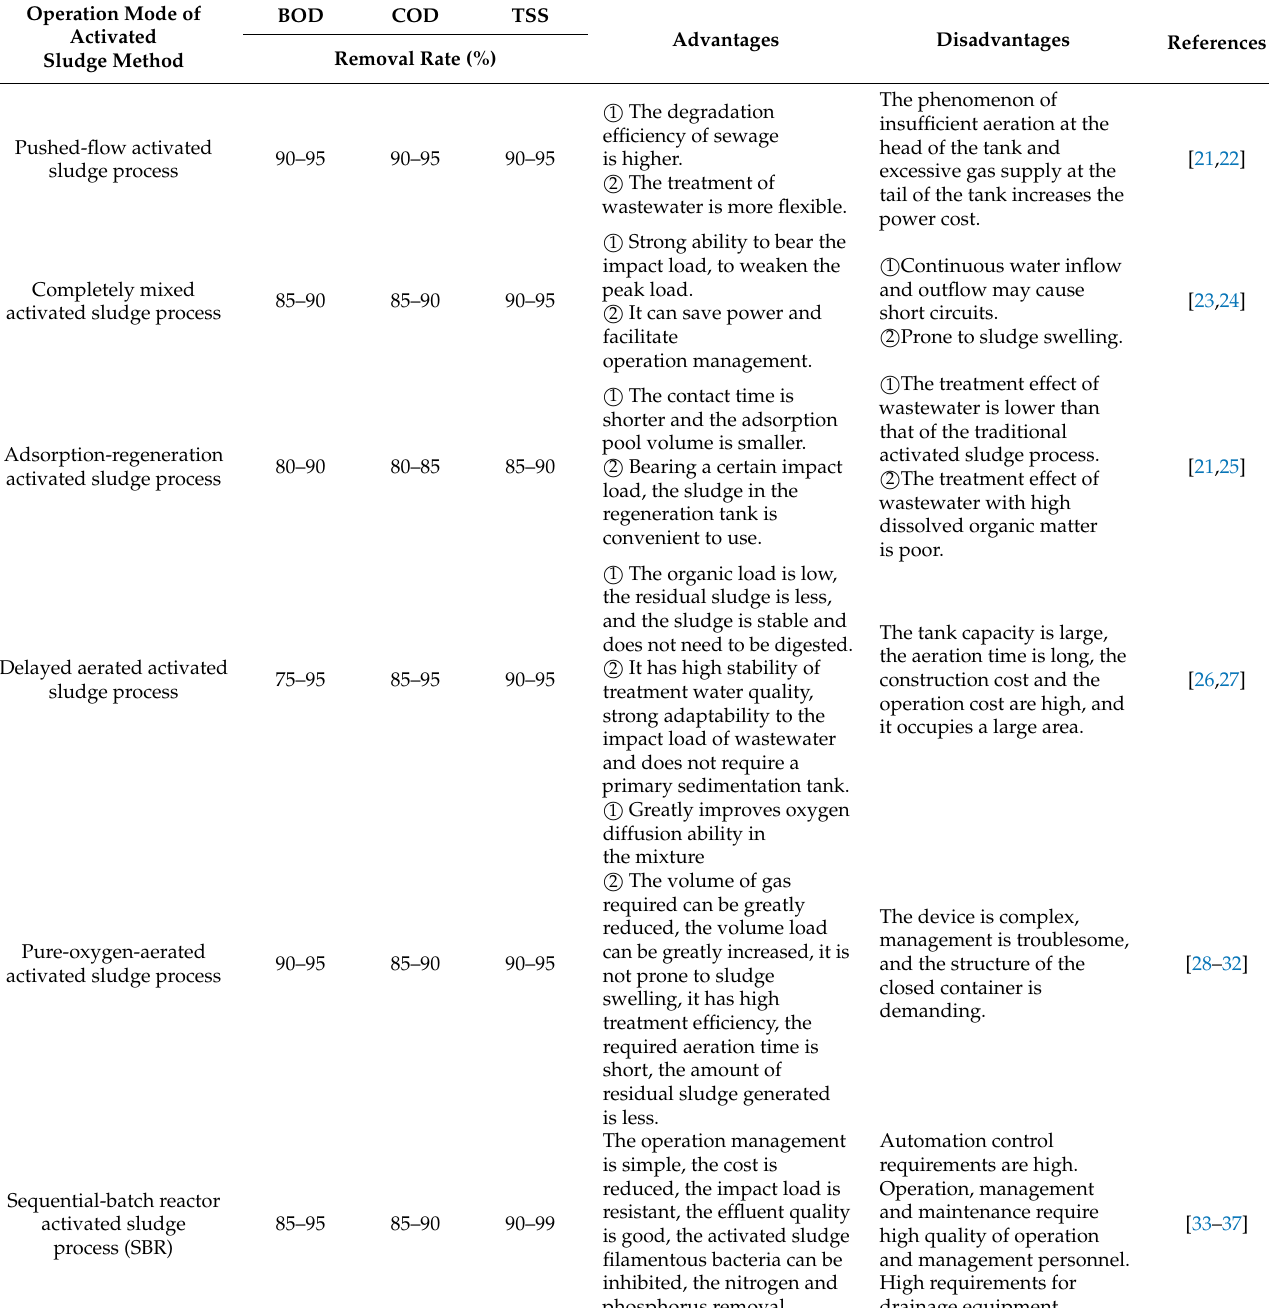
Table 1. Removal rate of BOD, COD, TSS and other pollution indicators in municipal sewage by activated sludge methods and their advantages and